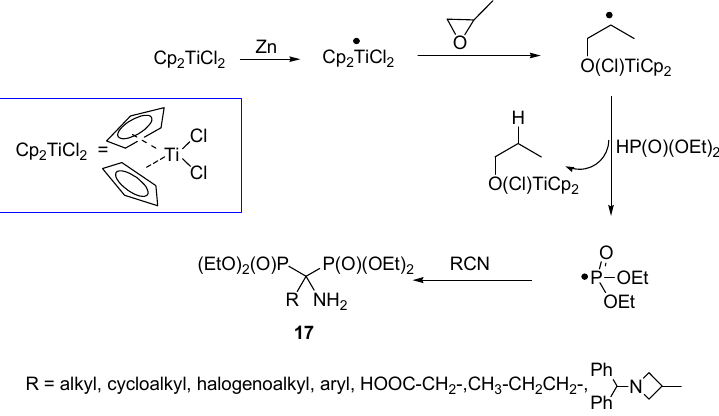
Scheme 10. Radical procedure for the synthesis of bisphosphonates from nitriles.